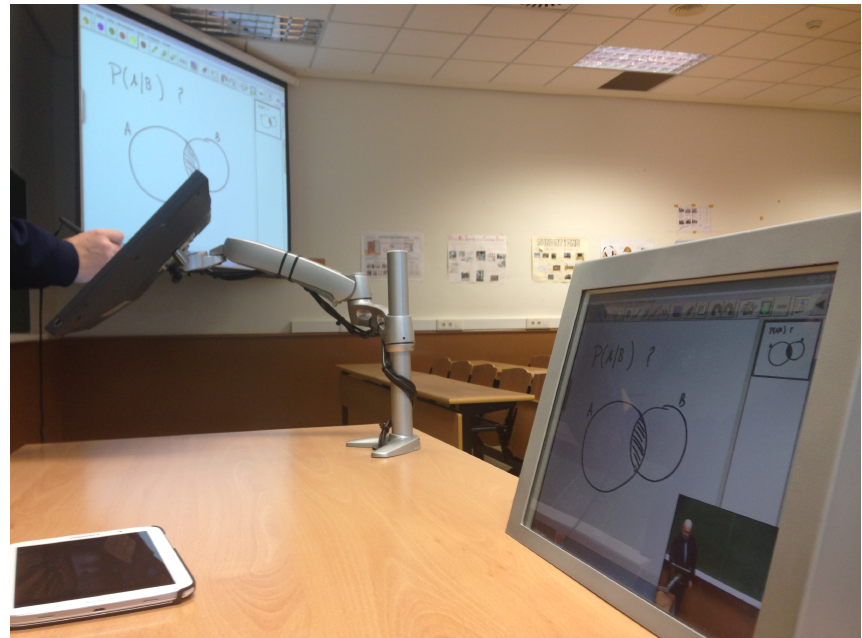
Figure 7. Communication by using an institutional